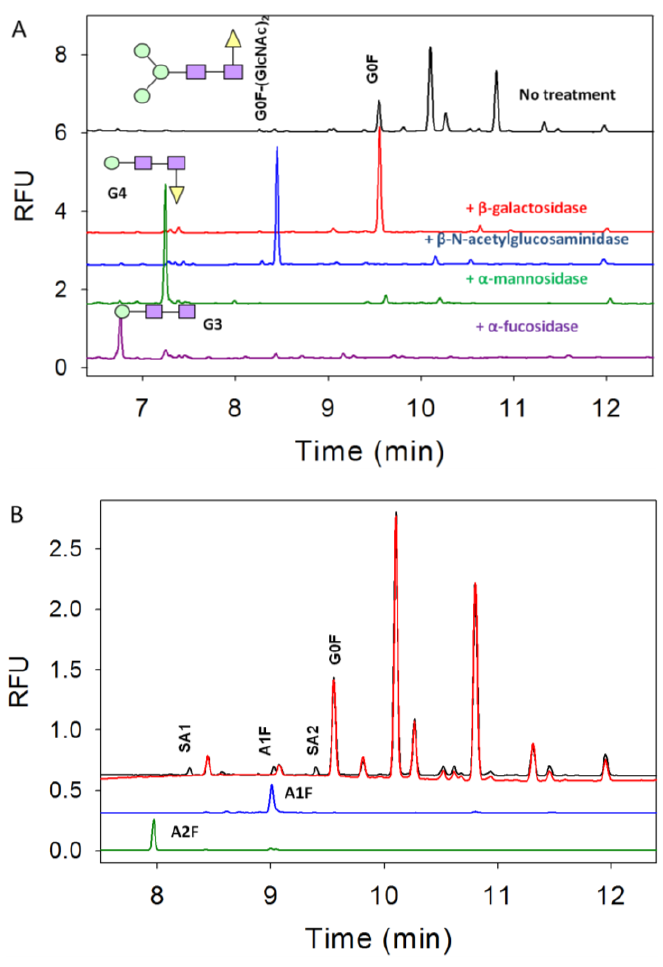
Figure 3. Exoglycosidase treatment of the N -glycan mixture. ( A ) Sequential treatment first with β-galactosidase (red trace), second with β- N -acetylglucosaminidase (blue trace), third with α-mannosidase (green trace), and finally with α-fucosidase (purple trace); ( B ) N -glycan mixture treated directly with α-neurominidase to remove sialic acid attached to the glycans. The non-treated sample (black trace) and treated sample (red trace) were overlaid illustrating that three peaks labeled as SA1, SA2, and A1F disappear upon treatment. A1F and A2F standards were run to compare and confirm the A1F